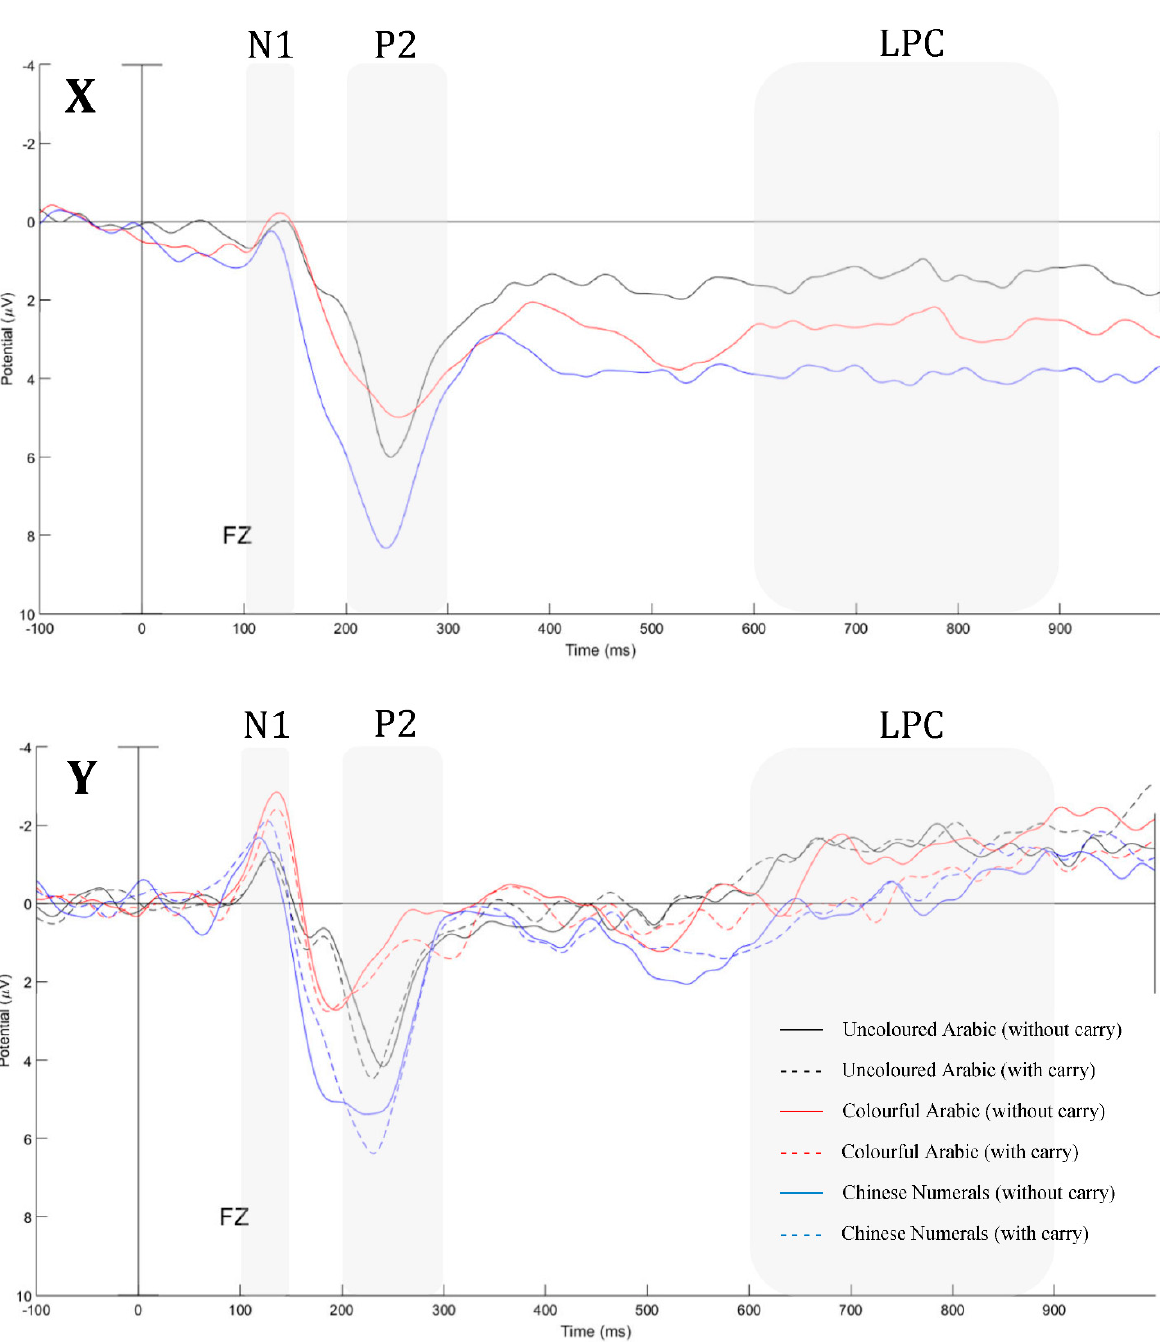
Figure 3. ERP waveforms averaged across participants elicited by the augend number (X) and the addend number (Y) at electrode Fz. Since there is no arithmetic related to the carry operation in the augend step (statistics results support this hypothesis), the without carry and with carry trials were combined in augend number (X).